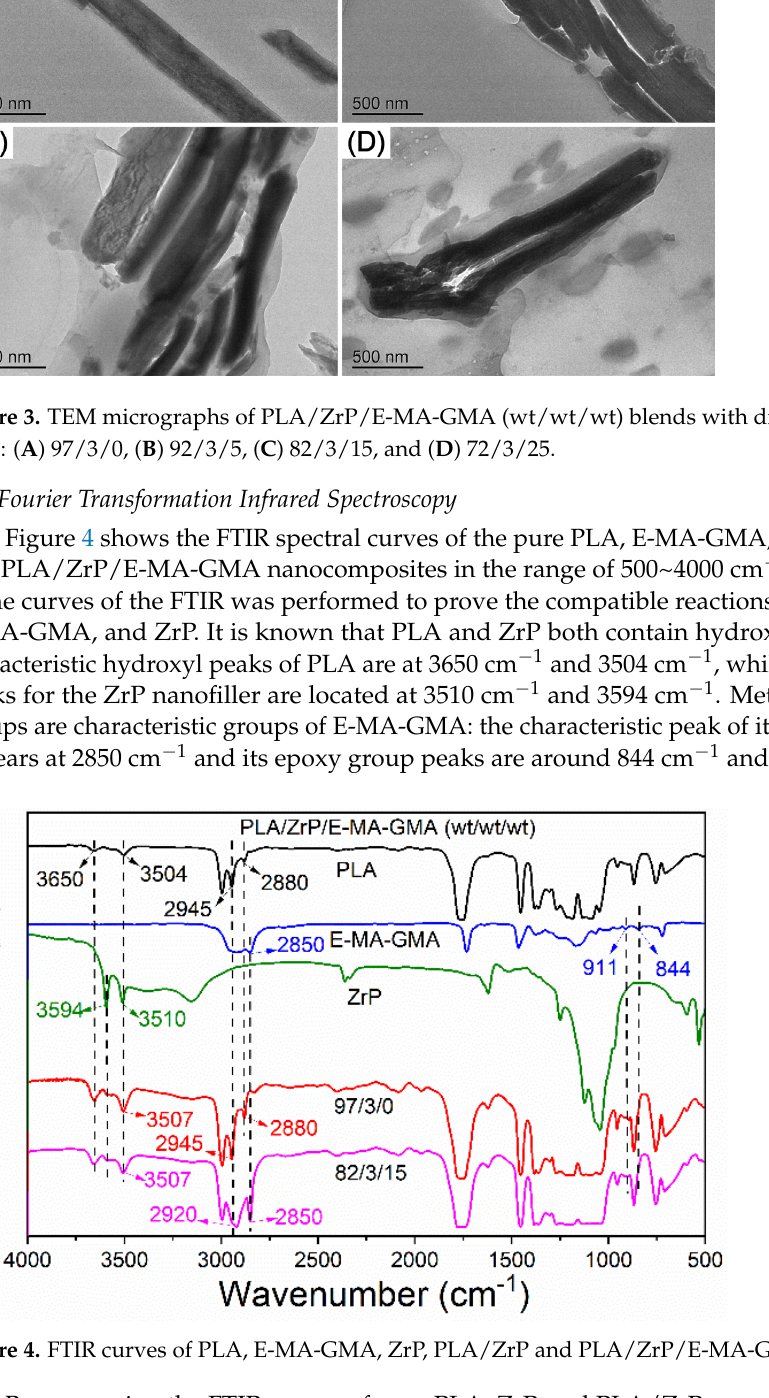
6 of 14 Figure 2. SEM micrographs of impact sections of PLA/ZrP/E − MA − GMA (wt/wt/wt) nanocompo- sites: ( A ) 97/3/0, ( B ) 92/3/5, ( C ) 82/3/15, and ( D ) 72/3/25. ( a – d ) are enlarged micrographs of ( A – D ), respectively. The microstructural morphology of the E − MA − GMA and ZrP nanofillers dispersed